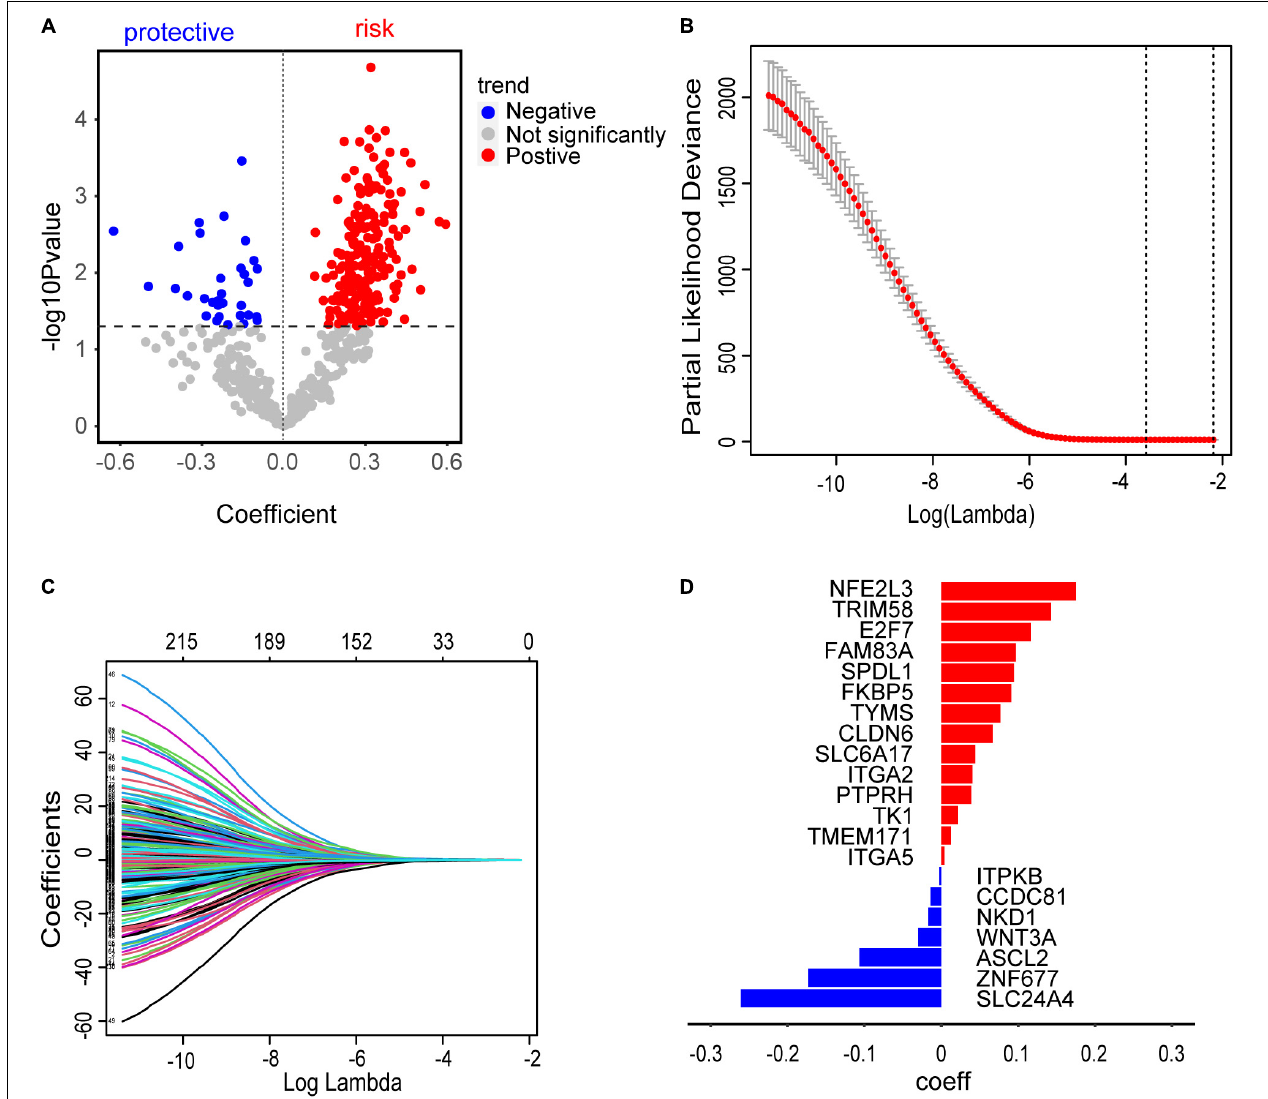
FIGURE 5 | Construction of risk assessment signature. (A) 241 promising candidates ( P ≤ 0.05), including 32 protective and 209 risk markers. (B) The optimal λ value of 0.02774519 was selected to identify the most robust markers for prognosis in LASSO regression. (C) A combination of 21 genes remained with their individual non-zero LASSO coefficients. (D) The distribution of LASSO coefficients of the gene signature. The blue bars represent protective biomarkers and the red bars represent risk